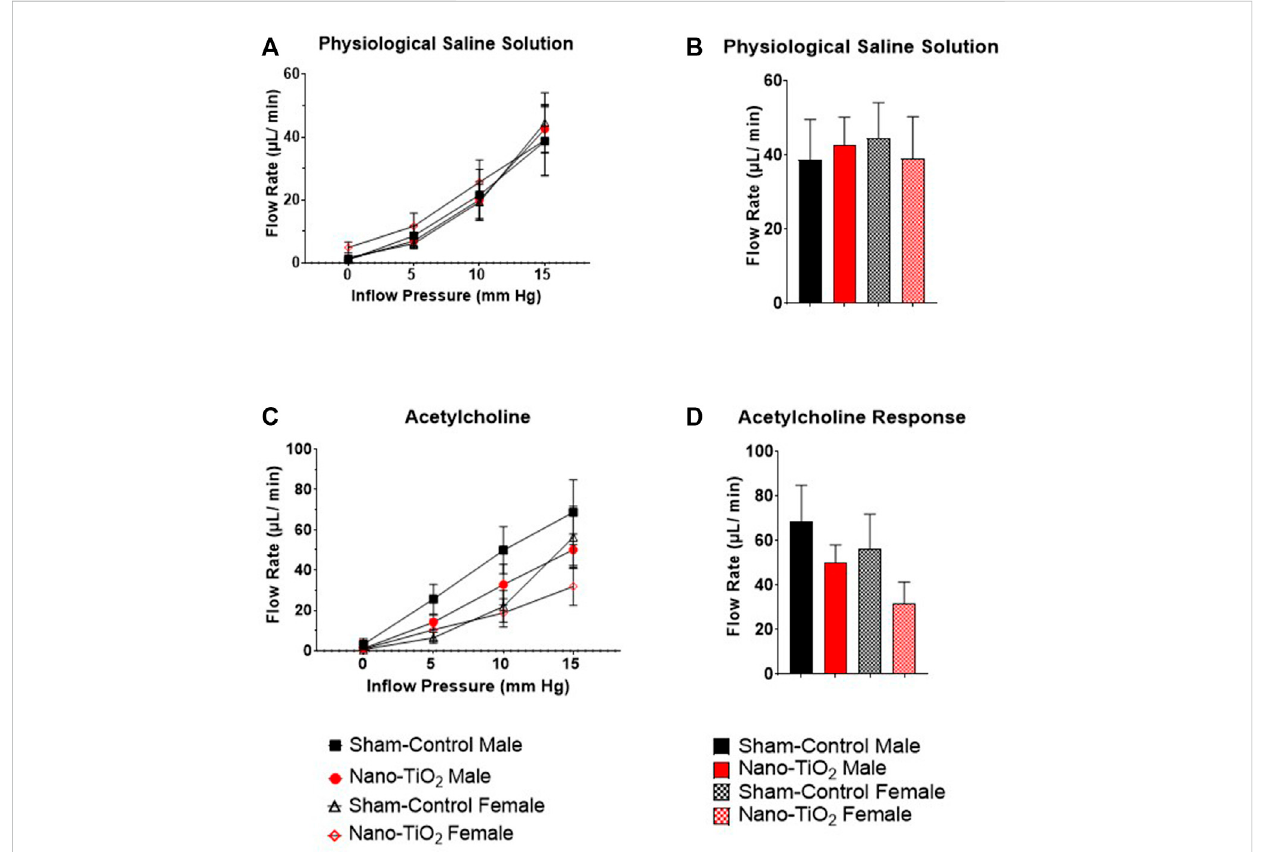
Placental fl ow rate hemodynamics. Flow rate was calculated and recorded throughout experiment as in fl ow pressure was increased stepwise manner. (A) Flow rate in PSS bathe. (B) Maximum fl ow rate response in PSS. (C) Flow rate of placentas in the presence of the ACh, an